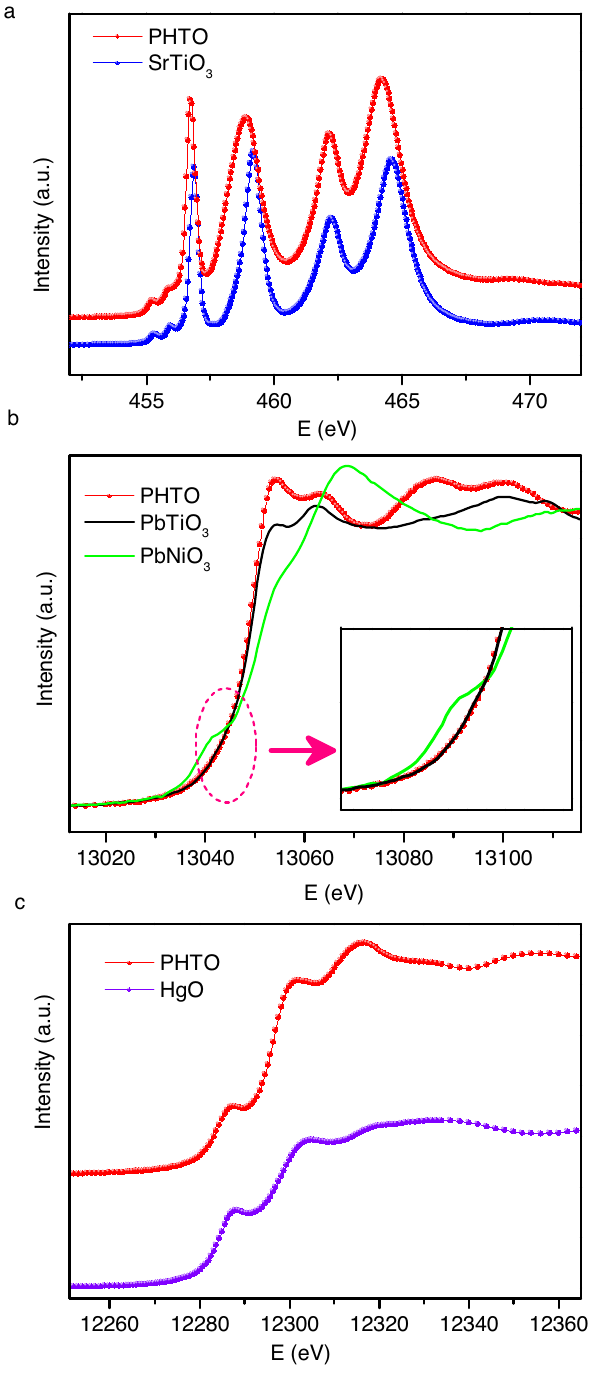
Fig. 3 X-ray absorption spectroscopy of PHTO. a Ti- L 2,3 edge. b Pb- L 3 edge. c Hg- L 3